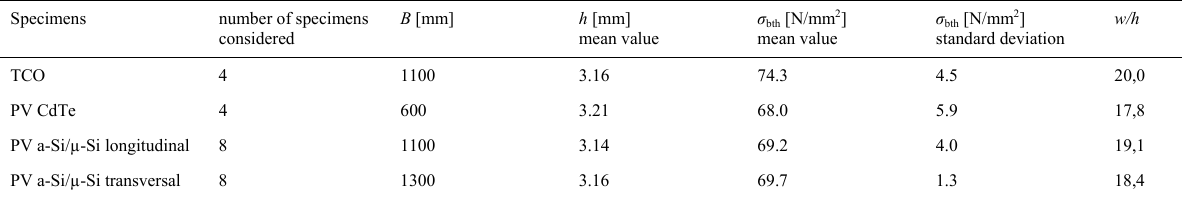
Table 4: Results of photovoltaic glasses in four point